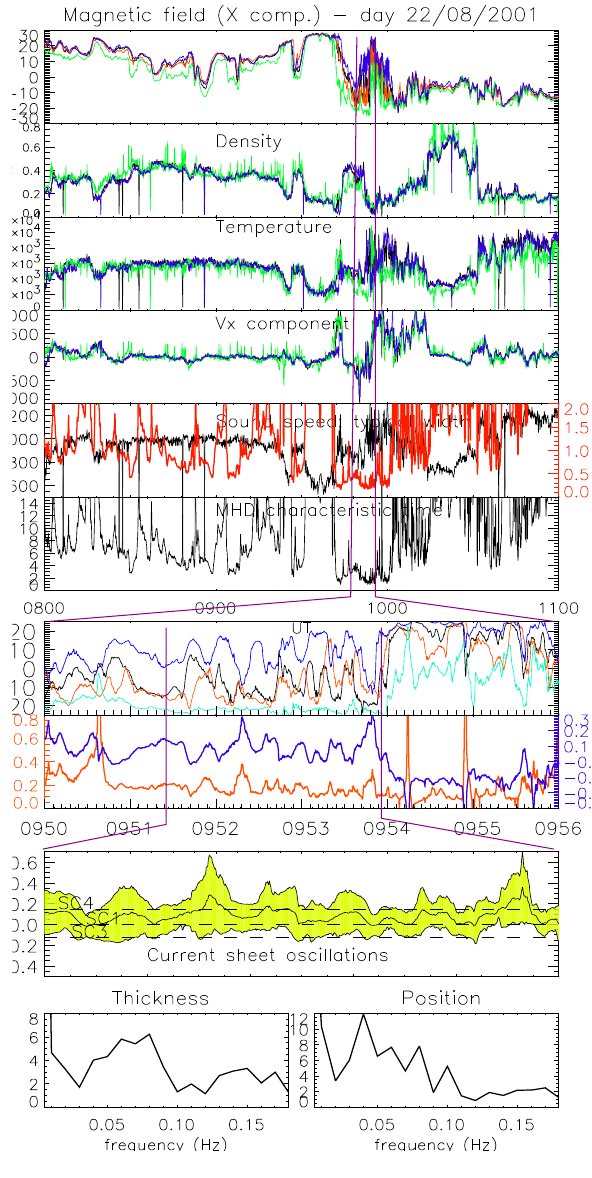
Fig. 22. Overview of the 22 August 2001 event. Panels 1 to 6: overview of the crossing. Panel (1): X component of the magnetic field (4 SC determinations), Panel (2): ion density (SC1, SC3 and SC4) Panel (3): ion temperature, Panel (4): ion velocity, Panel (5): sound speed (in black) and thickness of the sheet (in red), Panel (6): MHD characteristic time. Panels 7 to 9: Zoom on the oscillations. Panel (7): X component of the magnetic field, Panel (8): position (z, in blue) and half thickness (l, in red) of the sheet deduced from a fit with a Harris sheet, Panel (9): temporal evolution of the sheet. The vertical axis corresponds to Z (gsm). The colored area represents the sheet, localized between z-l (lower limit) and z+l (upper limit). The central line is z. Panel (10): spectral analysis of the position and thickness. (From Louarn et al.,